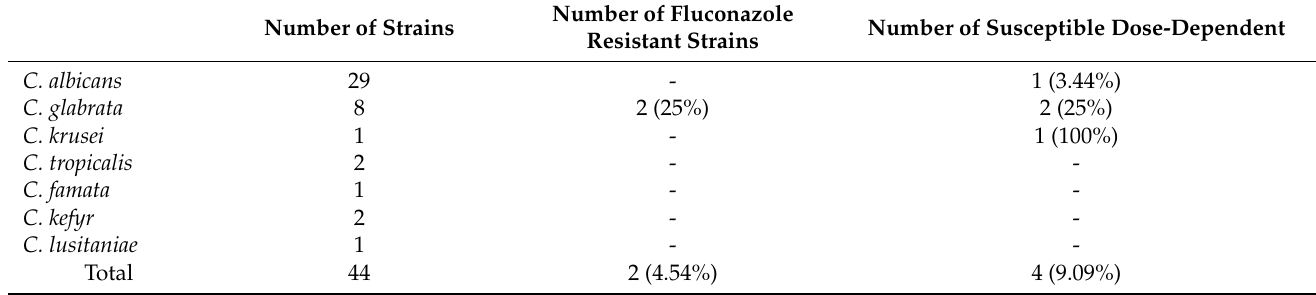
Table 1. Total number of test strains and fluconazole resistance